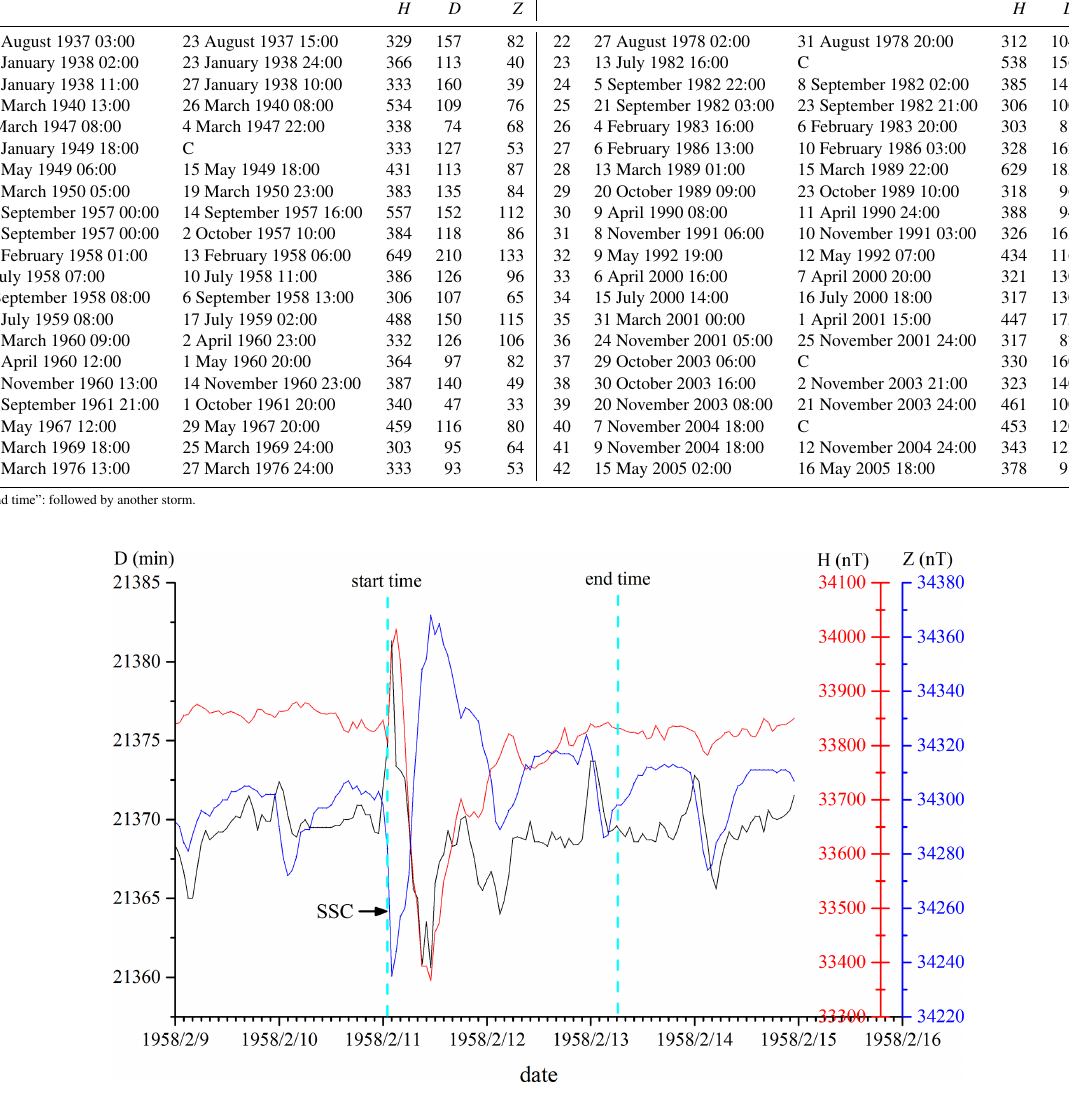
Figure 17. The geomagnetic storm occurred on 11 February 1958.